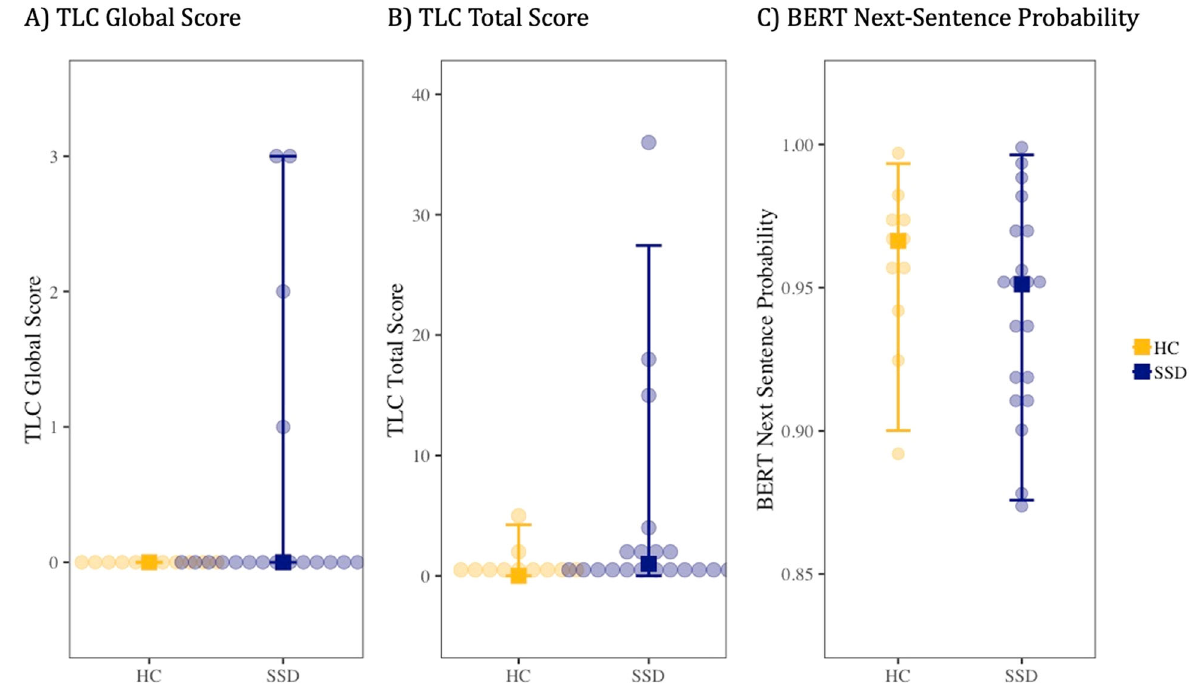
Fig. 1 Group effects on clinical language ratings and BERT next-sentence probability. Individual scores with group median and interquartile range are shown. There were no signi fi cant group differences for ( A ) TLC Global Score (Cohen ’ s d = 0.55, p = 0.13), ( B ) TLC Total Score or Sum (Cohen ’ s d = 0.48, p = 0.10), and ( C ) BERT Next-Sentence Probability (Cohen ’ s d = − 0.44, p = 0.25). The three SSD participants with TLC global scores ≥ 2 were identi fi ed as outliers. Table 2. Parts-of-speech frequencies in SSD and HC.